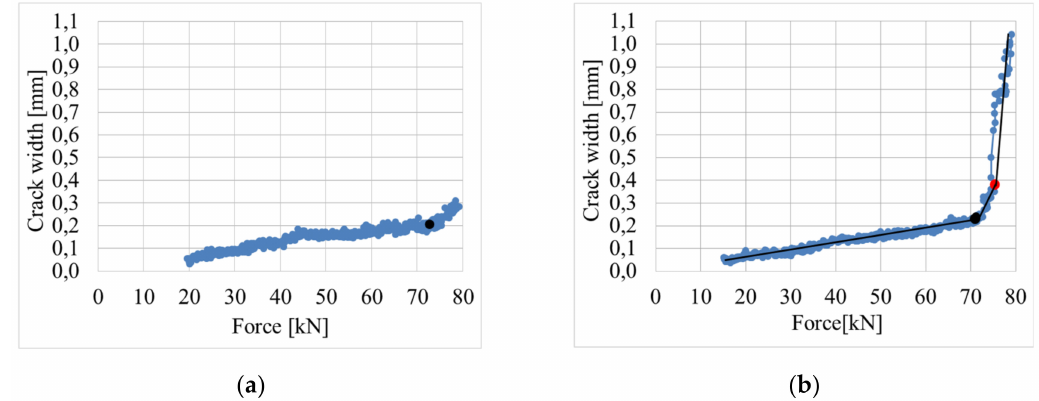
Figure 29. Increase in the width of cracks on beam D2M-2 during loading ( a ) crack no. 2; ( b ) crack no. 14.